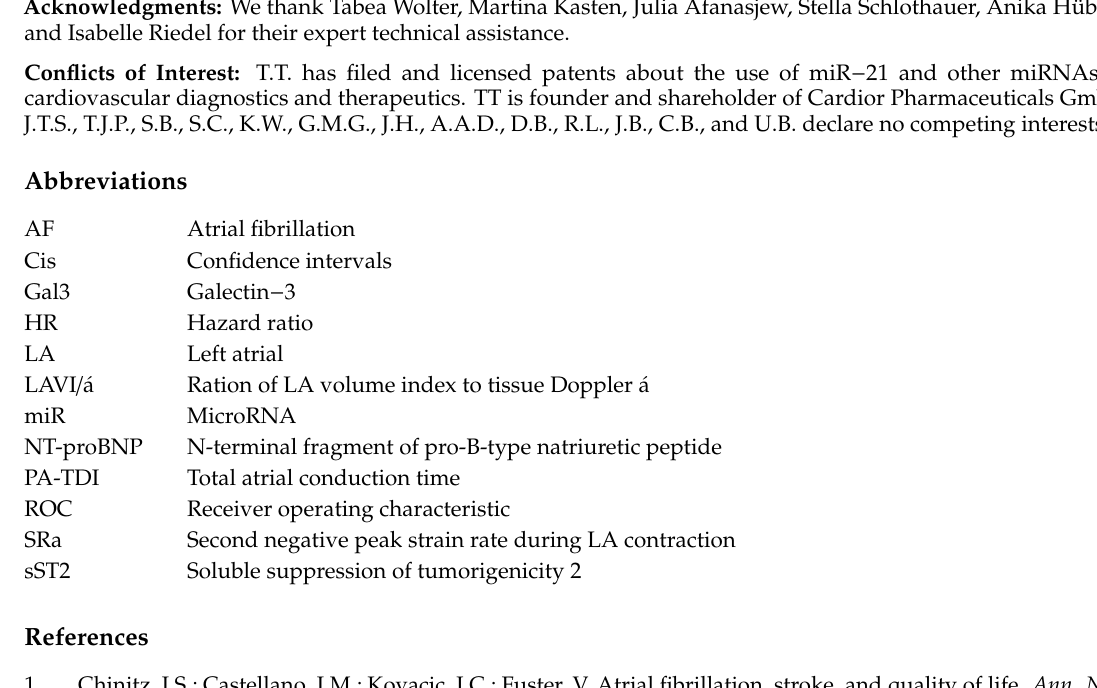
Table S1: Regression analysis of training and test set, Table S2: ROC-analysis of training and test set, Table S3: Mc Nemar test for dependent samples, Table S4: Medication documented at study